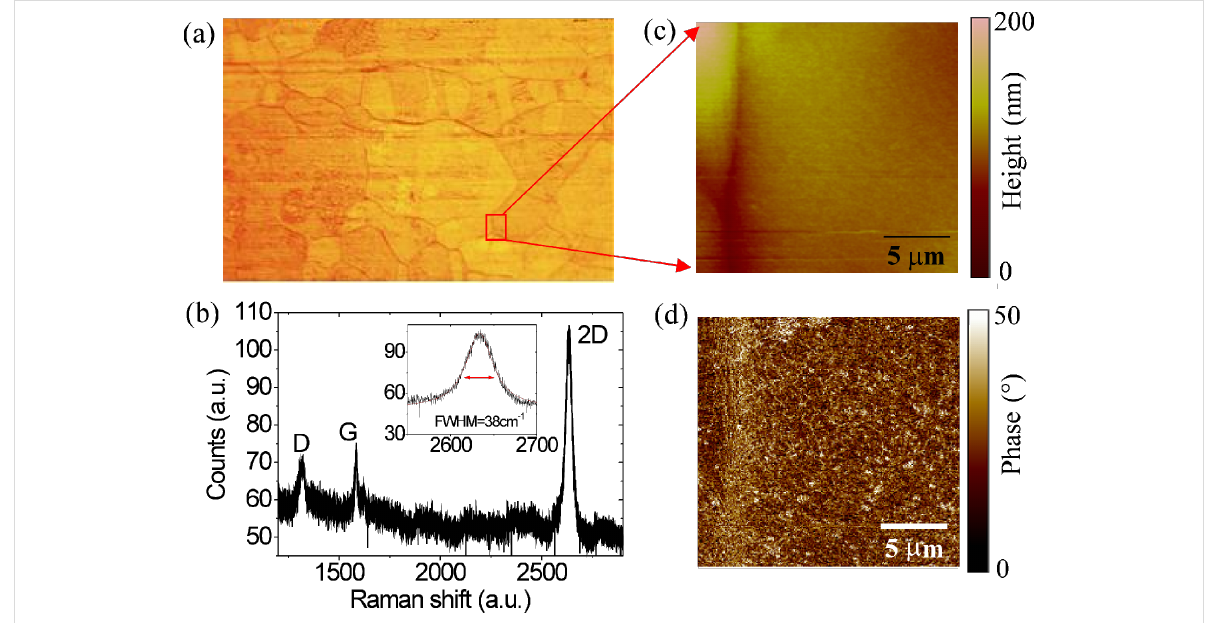
Figure 1: As-grown graphene on a copper foil: (a) Optical image, (b) Raman Spectroscopy, (c) AFM morphology and (d)